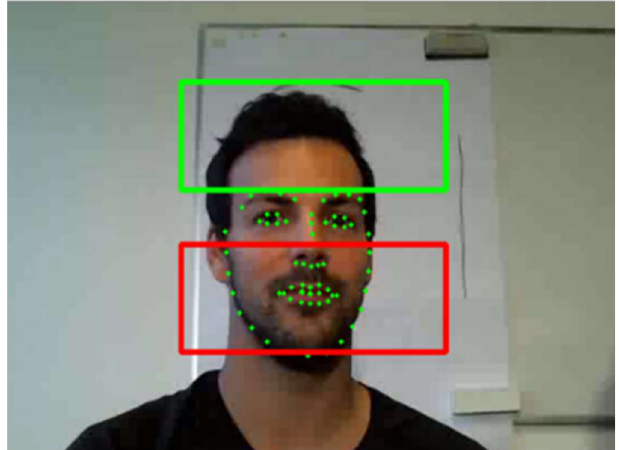
Figure 4. Preprocessing of the COHFACE dataset. Green dots are decided by the facial recognition library of “dlib.” The forehead and cheeks of the subject are detected by the green and red areas shown above.